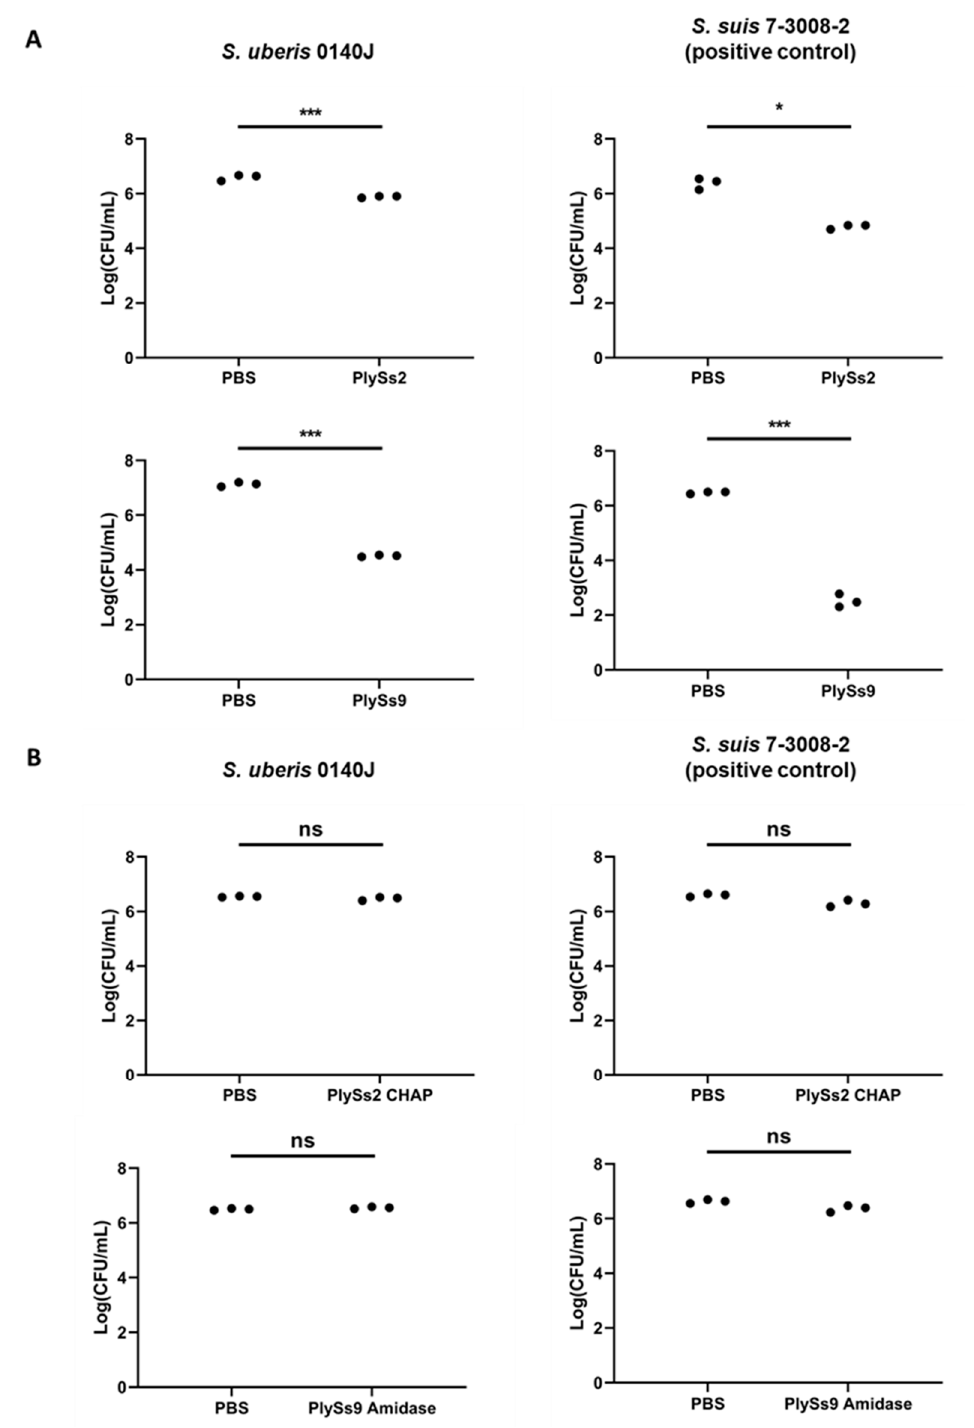
Figure 4. Time killing assays with PlySs2 and PlySs9 ( A ), and PlySs2 CHAP and PlySs9 amidase ( B ) for 2 h at 37 °C on stationary phase S. uberis 0140J. S. suis 7-3008-2 served as the positive control and bacteria in PBS were included as negative controls. 10 6 CFU/mL were challenged with 0.5 µM enzyme. * indicates p < 0.05, *** indicates p < 0.001 and ‘ns’ indicates non-significant corresponding to a p >